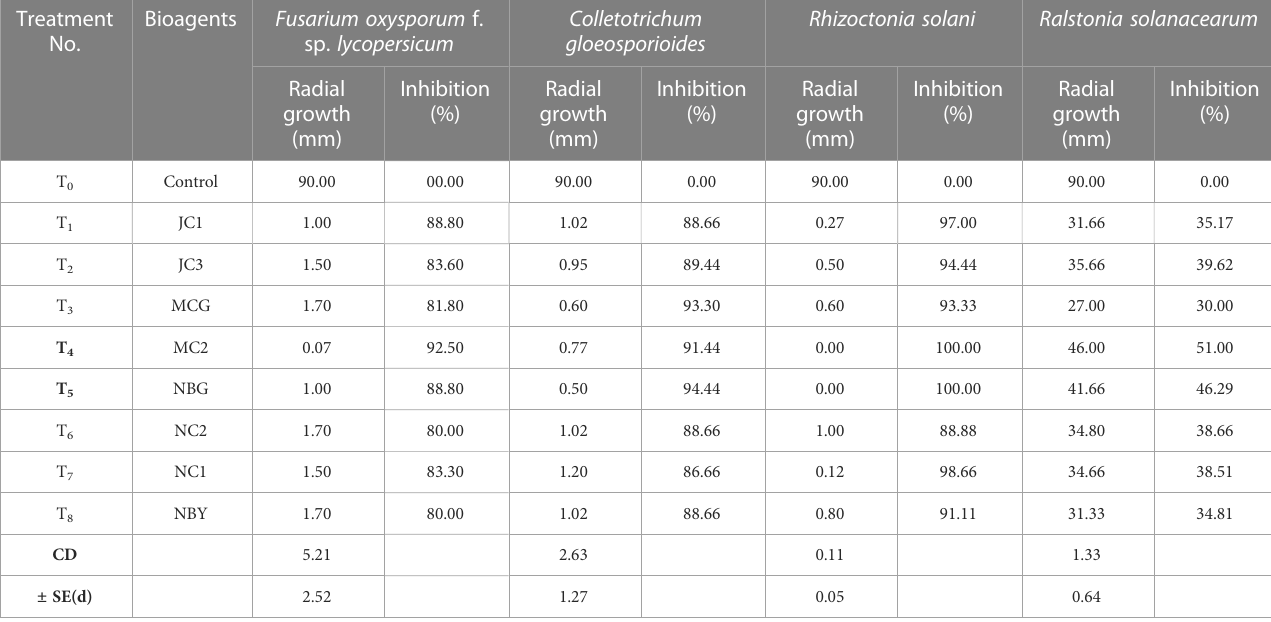
TABLE 3 Antagonistic activity of the eight fungal isolates against pathogens causing diseases in solanaceous crops. Treatment